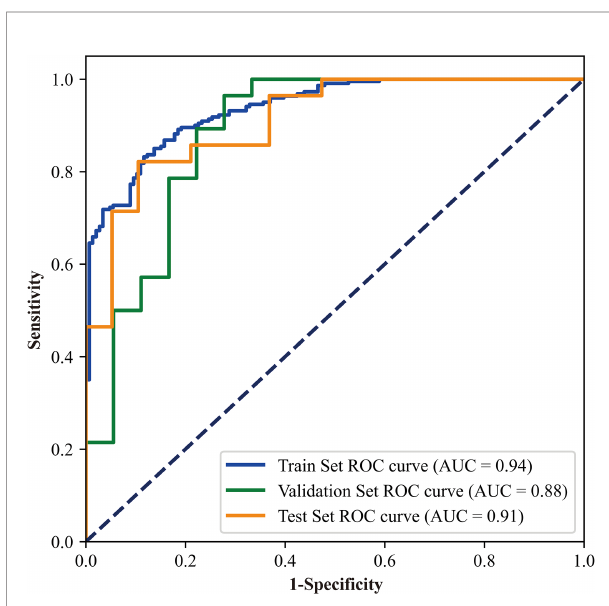
FIGURE 6 | The receiver operating characteristic curves of the CNN model used in this study.